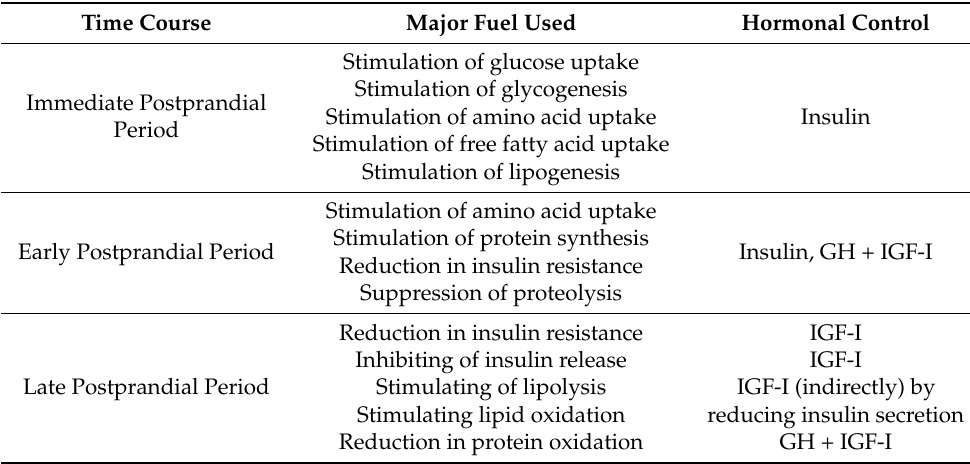
Table 1. The three phases of the “Food and Famine” theory. Time Course Major Fuel Used Hormonal Control